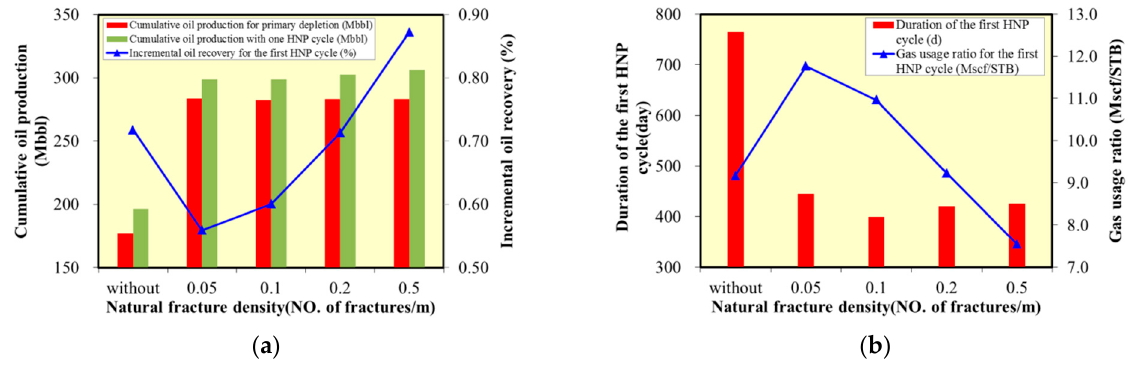
Figure 14. Correlation between natural fracture density and huff-n-puff results: ( a ) Cumulative oil production and incremental oil recovery for different natural fracture densities; ( b ) Duration of the first huff-n-puff cycle and gas usage ratio for different natural fracture densities.